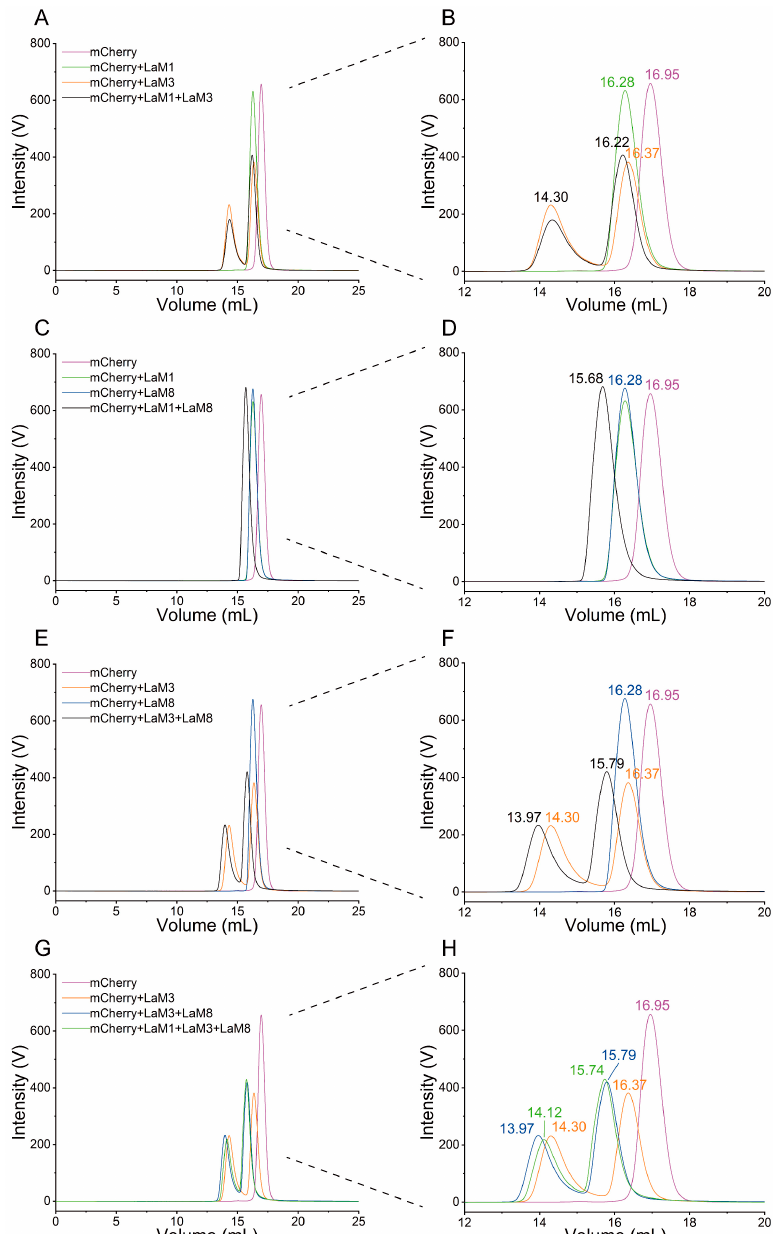
Figure 3. Verify the binding of mCherry to LaM nanobodies by fluorescence-detected size exclusion chromatography. The x -axis represents elution volume, and the y -axis represents the detected fluorescence intensity by the fluorescence detector. Panels ( A , C , E ), and ( G ) show the FSEC profiles of mCherry with or without LaMs, while panels ( B , D , F ), and ( H ) zoom in on the details of the 12–20 mL range for the corresponding FSEC sub-figures. Panels ( A , B ) compare the elution volume of mCherry with that of mCherry-LaM1, mCherry-LaM3, and the mCherry-LaM1/LaM3 complex; panels ( C , D ) compare the elution volume of mCherry with that of mCherry-LaM1, mCherry-LaM8, and the mCherry-LaM1/LaM8 complex; panels ( E , F ) compare the elution volume of mCherry with that of mCherry-LaM3, mCherry-LaM8, and the mCherry-LaM3/LaM8 complex; panels ( G , H ) compare the elution volume of mCherry with that of mCherry-LaM3, the mCherry-LaM3/LaM8 complex, and the mCherry-LaM1/LaM3/LaM8 complex.